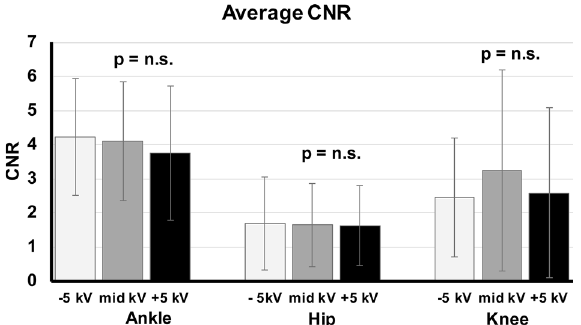
Figure 5. Average CNR of the image triplets of the ankles, hips and knees. CNR calculated between trabecular bone and soft tissue mantle showed no significant changes within the image triplets (with ± 5 kV tube voltage variation) in ankle, hip and